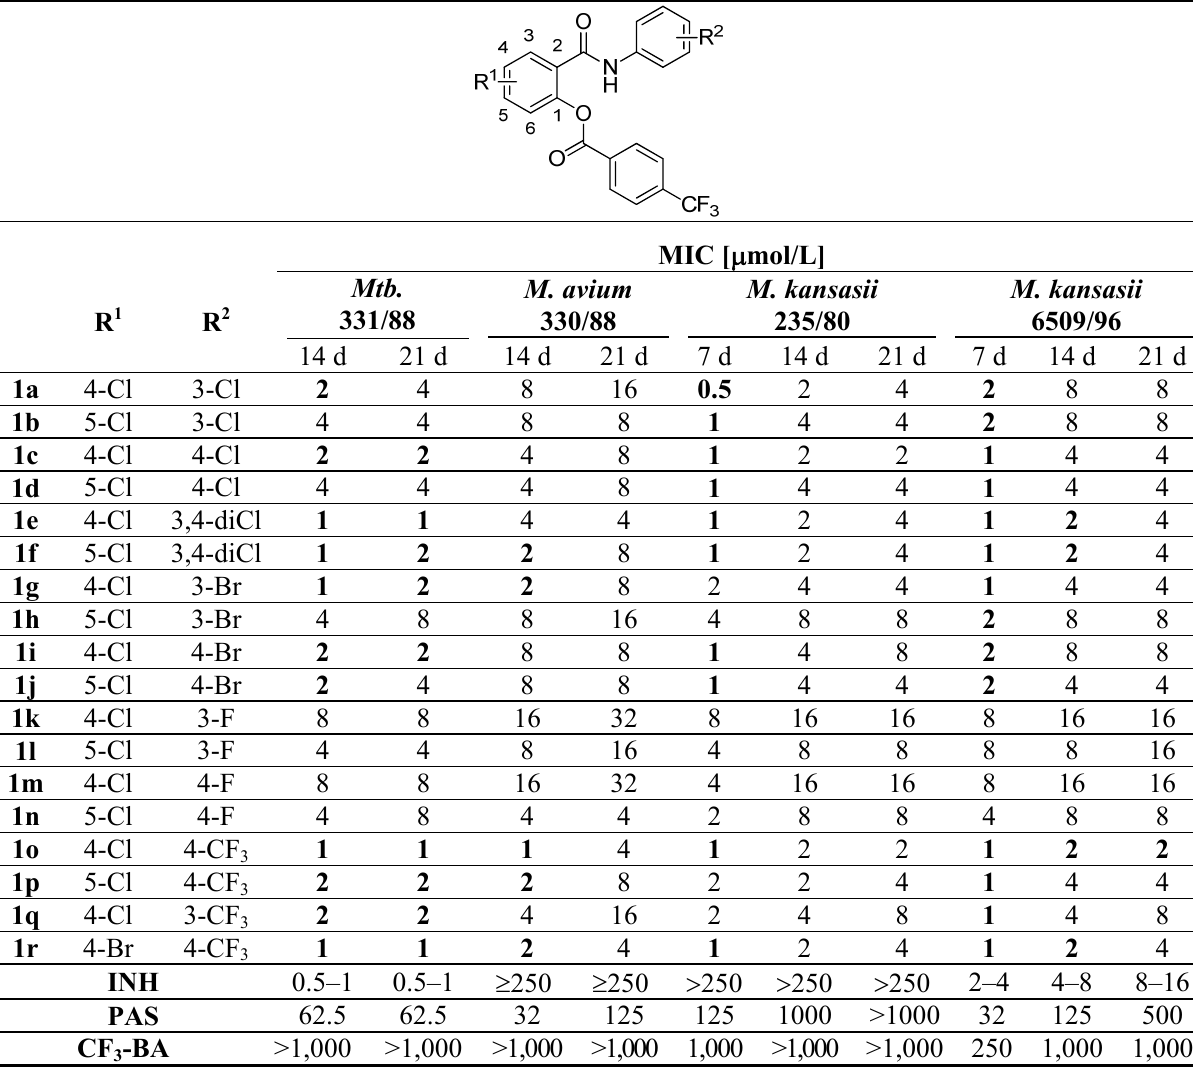
Table 1. Antimycobacterial activity of salicylanilide 4-(trifluoromethyl)benzoates 1